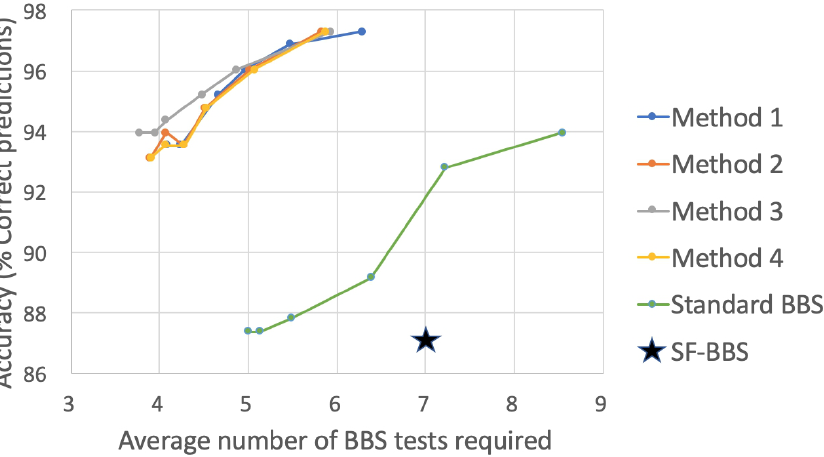
Figure 7. Accuracy vs. average number of BBS tests for different selector methods (Section 5.2) trained on the physiotherapist scoring. For each method, the plot shows values for 6 different confidence thresholds (90, 92, 94, 96, 98, and